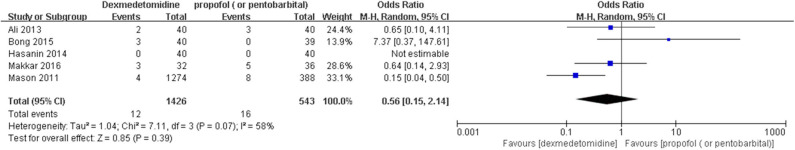
Comparison of pediatric EA or ED between dexmedetomidine and propofol (or pentobarbital) groups.